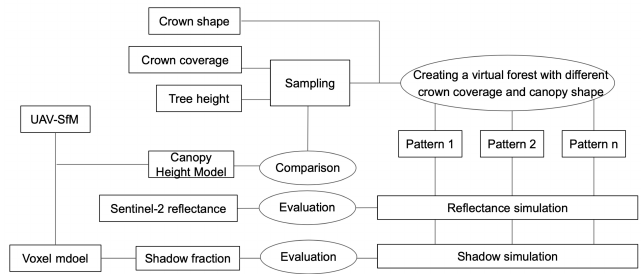
Figure 1. Flow chart of this study.